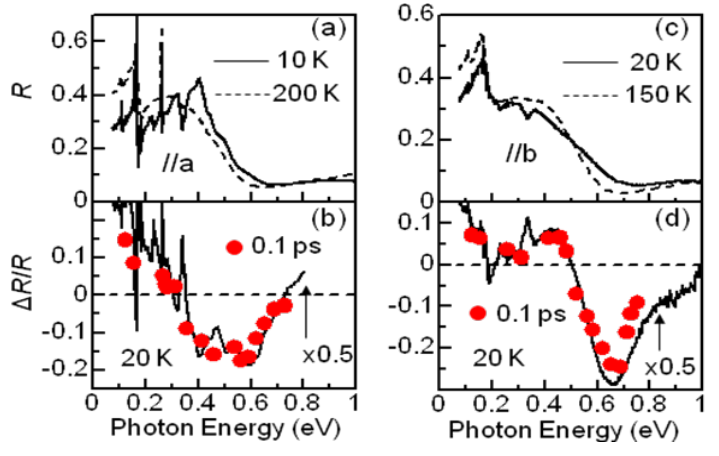
Figure 7. Reflectivity spectra of ( a ) α-(ET) measured at t = 0.1 ps (20 K) are shown as red circles for ( b ) α-(ET) d ( d ) θ - (ET) RbZn(SCN) . Excitation energy E 2 4 and 0.1 mJ/cm 2 . Differential spectra ( R shown in ( b ) and ( d ) as solid